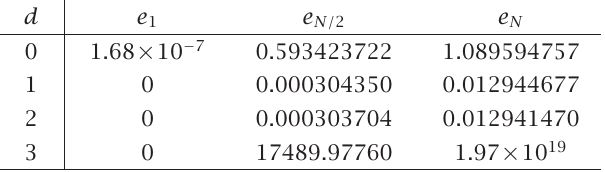
Table 4.3 . Approximate error when m = 2 and (Radau II parameters) ( { c 1 / 3 , c 2 = 1 } ) .